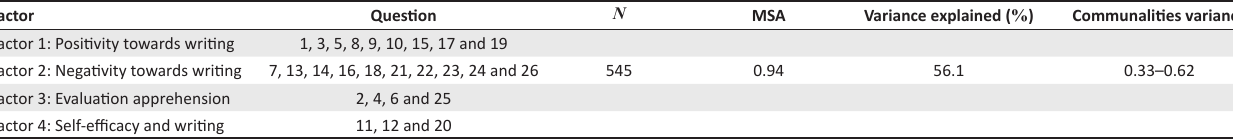
TABLE 2: Exploratory factor analysis and Kaiser’s measure of sample adequacy.